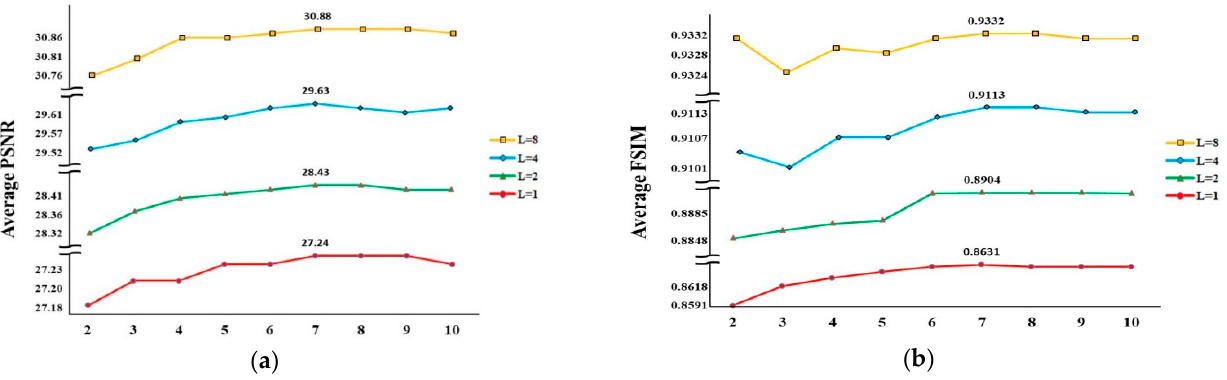
Figure 5. A comparison of the despeckling results with the parameter C ranging from 2 to 10. ( a ) Average Peak Signal-to-Noise Ratio (PSNR) values; ( b ) Average Feature Similarity Index (FSIM) values.